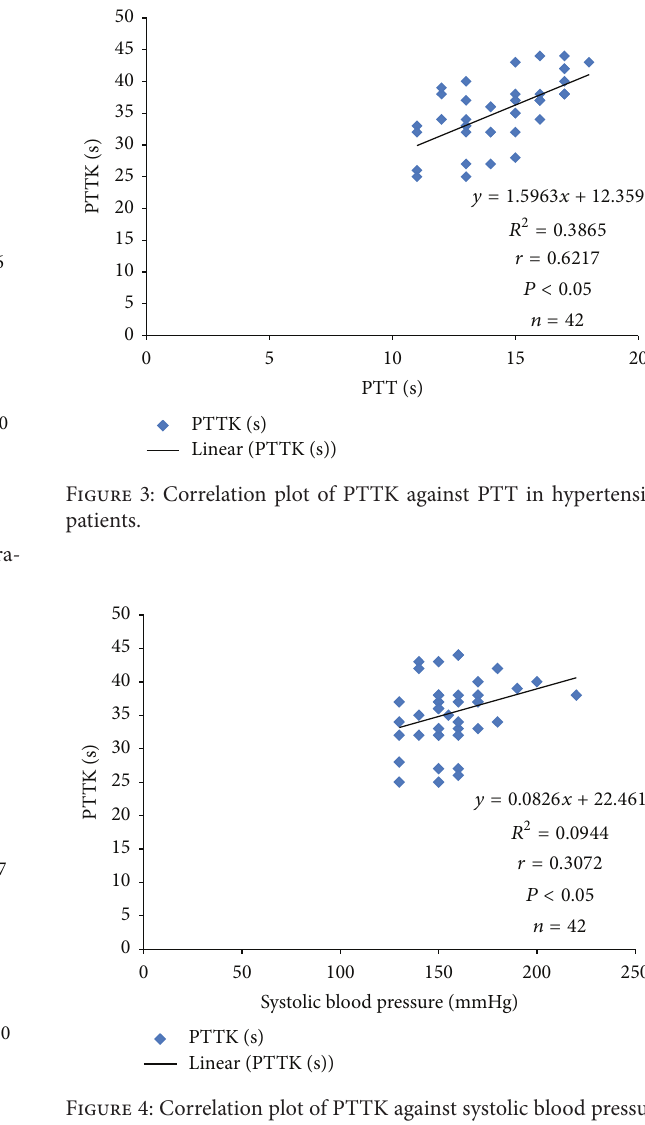
Figure 4: Correlation plot of PTTK against systolic blood pressure in hypertensive